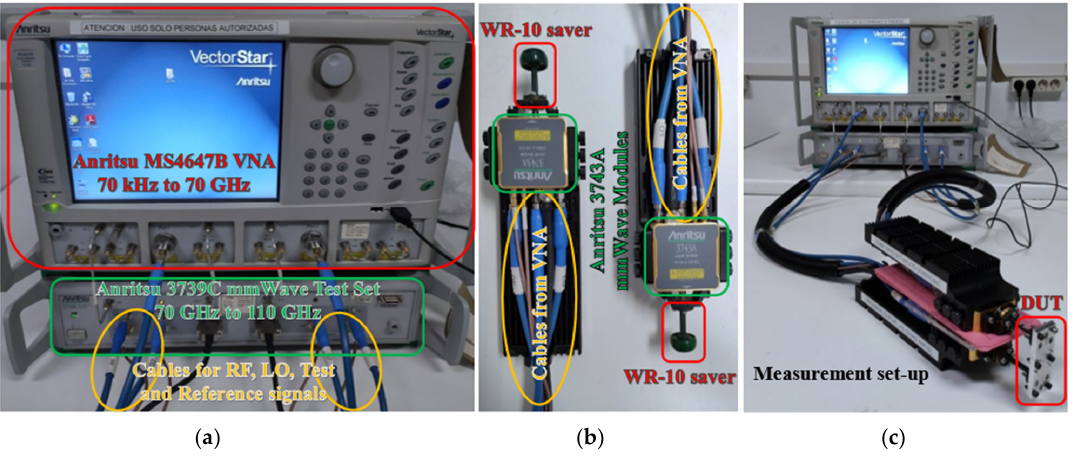
Figure 33. Images of the measuring and assembly equipment. ( a ) VNA and frequency extender, ( b ) measurement heads and ( c ) filter measurement set-up.